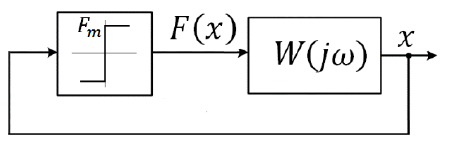
Figure 12. Frequency response of a nonlinear link.